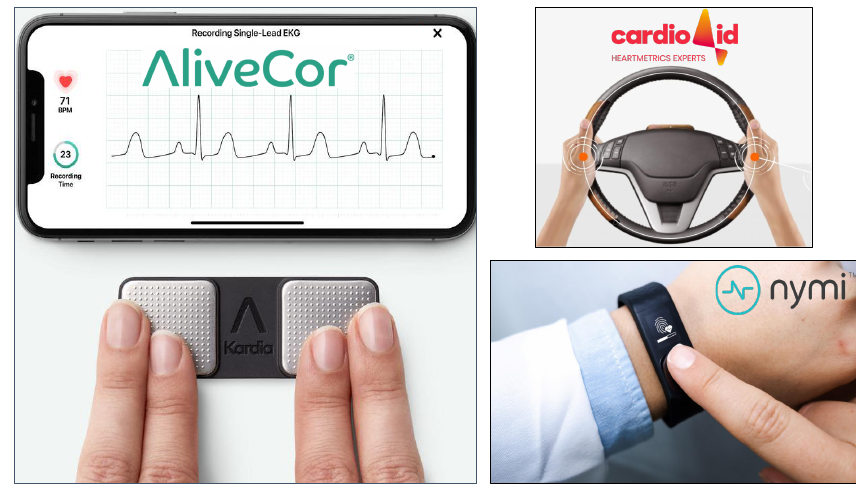
Figure 12. Alivecor, CardioID, and NYMI product